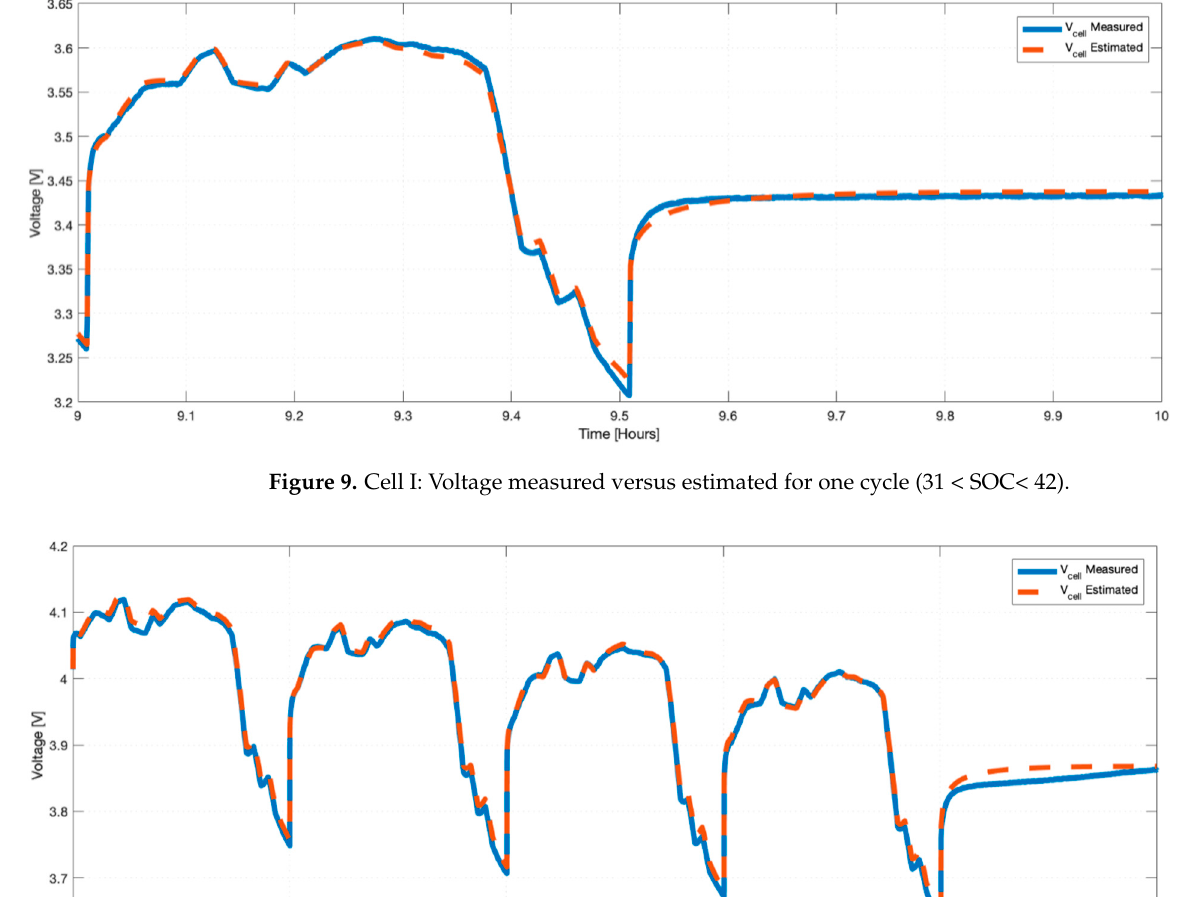
Figure 10. Cell II: Voltage measured versus estimated for 4 cycles.